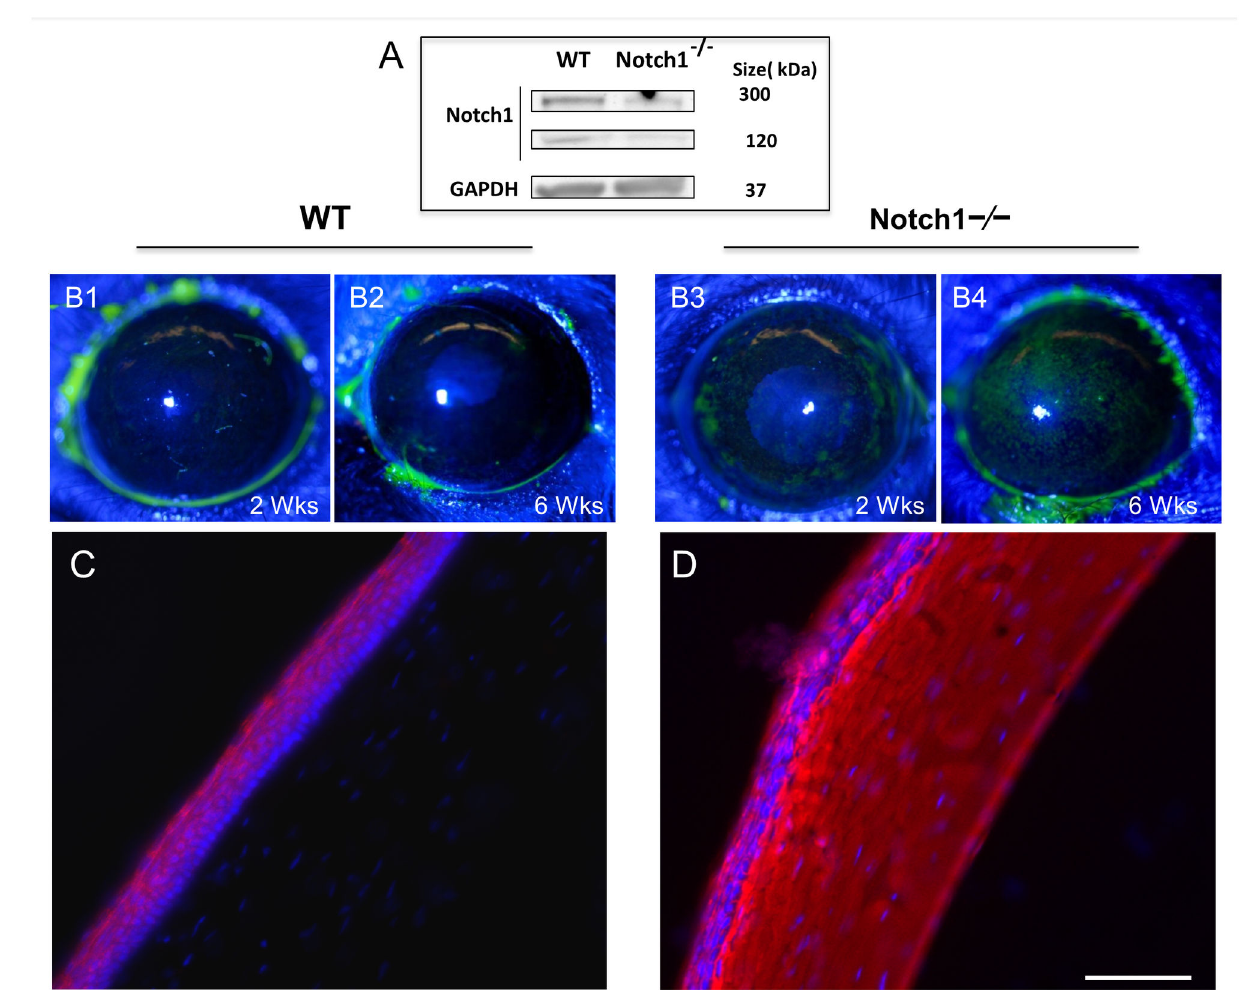
Figure 1. Notch1 deletion in the corneal epithelium leads to progressive barrier impairment. Notch1 knockout efficiency was evaluated by western blotting of pooled corneal epithelial sheets (N=8 per group) from conditional Notch1 -/- mice showing 64% to 70% decrease in Notch 1 expression comparing to epithelial sheets from WT littermates (A). Compared to WT (B1, B2), Notch1 deleted corneas demonstrate increased fluorescein staining at 2 (B3) and 6 (B4) weeks after 4-OHT treatment. LC-biotin (stained red with rhodamine) could not penetrate beyond the top few layers of the epithelium in WT mice (C) while it passed the epithelium and reached the stroma in Notch1 -/- mice at 4 weeks after Notch1 deletion (D). Red: rhodamine. Blue: DAPI; Scale bar: 50 µm.